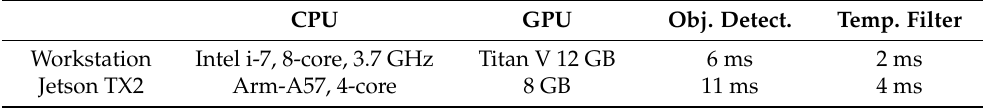
Table 2. Per-frame processing time comparison on the workstation and TX2. Video resolution: 1024 ×